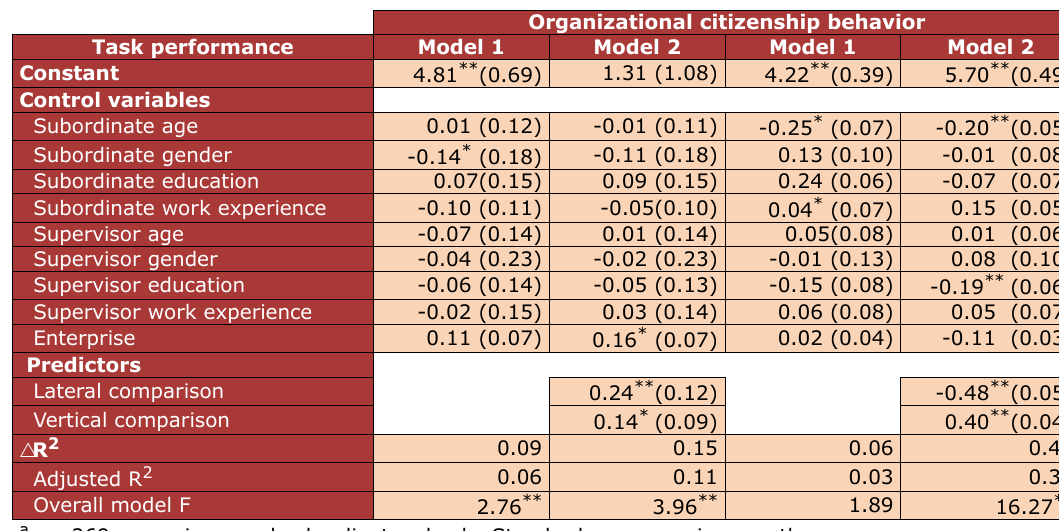
Table 3. Results of Linear Regression for Study 2: effects of lateral comparison and vertical comparison on employees’ task performance and